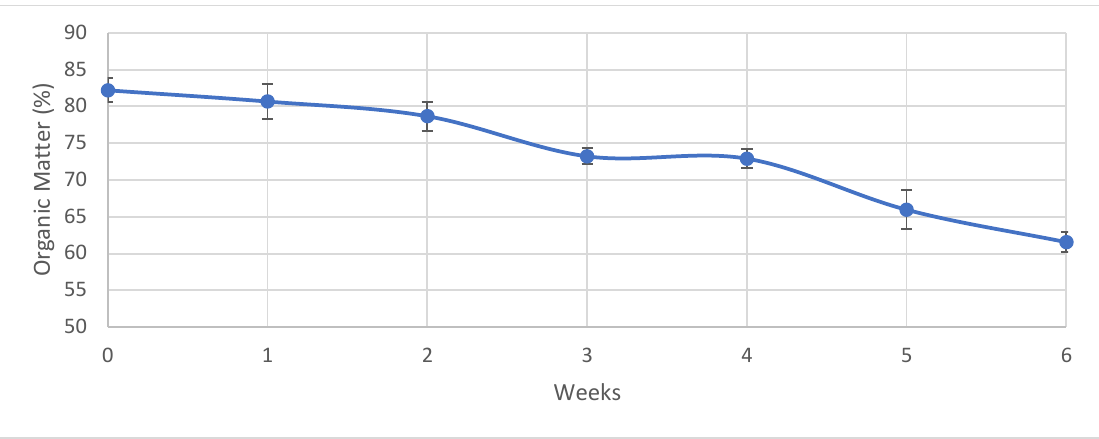
Figure 4. Corn cob waste organic matter behavior in pre-composting.